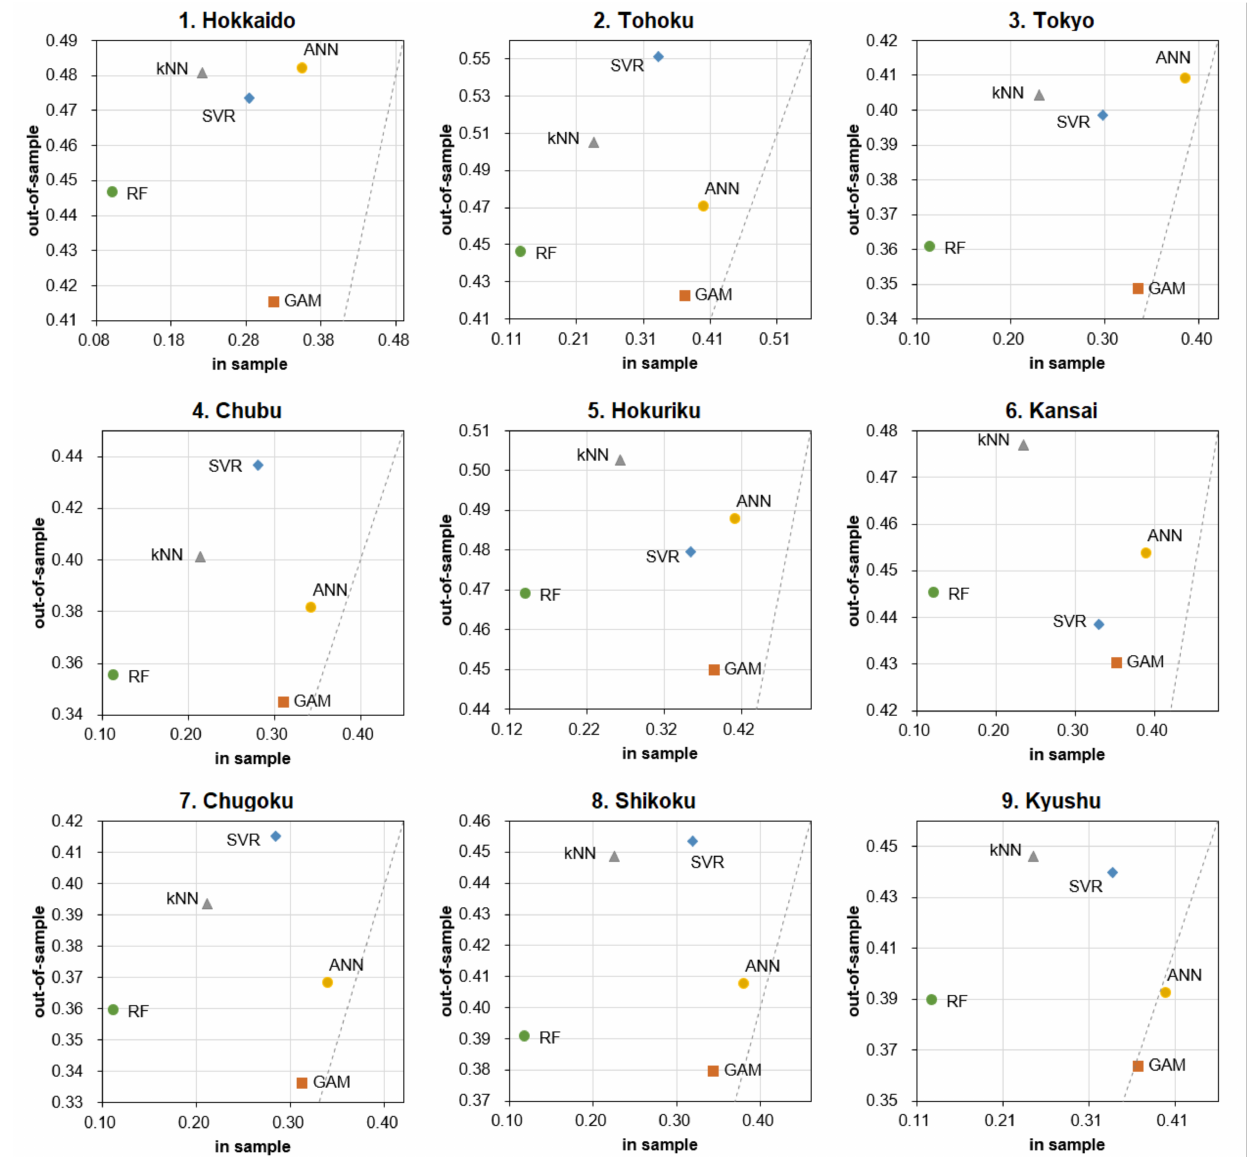
Figure 4. RMSE of each method on PV power generation in nine